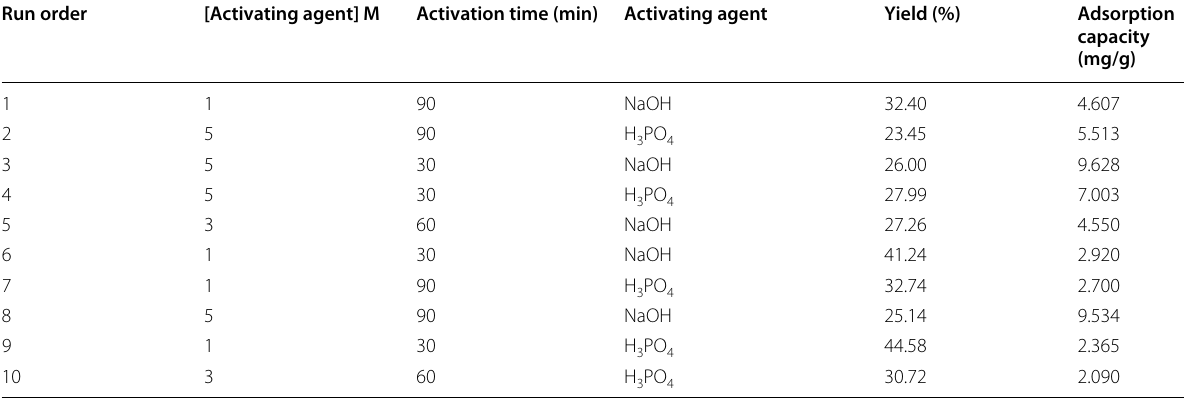
Table 2 Experimental design matrix and responses for the preparation of Dialium Guineense pods activated carbon (DGPAC) Run